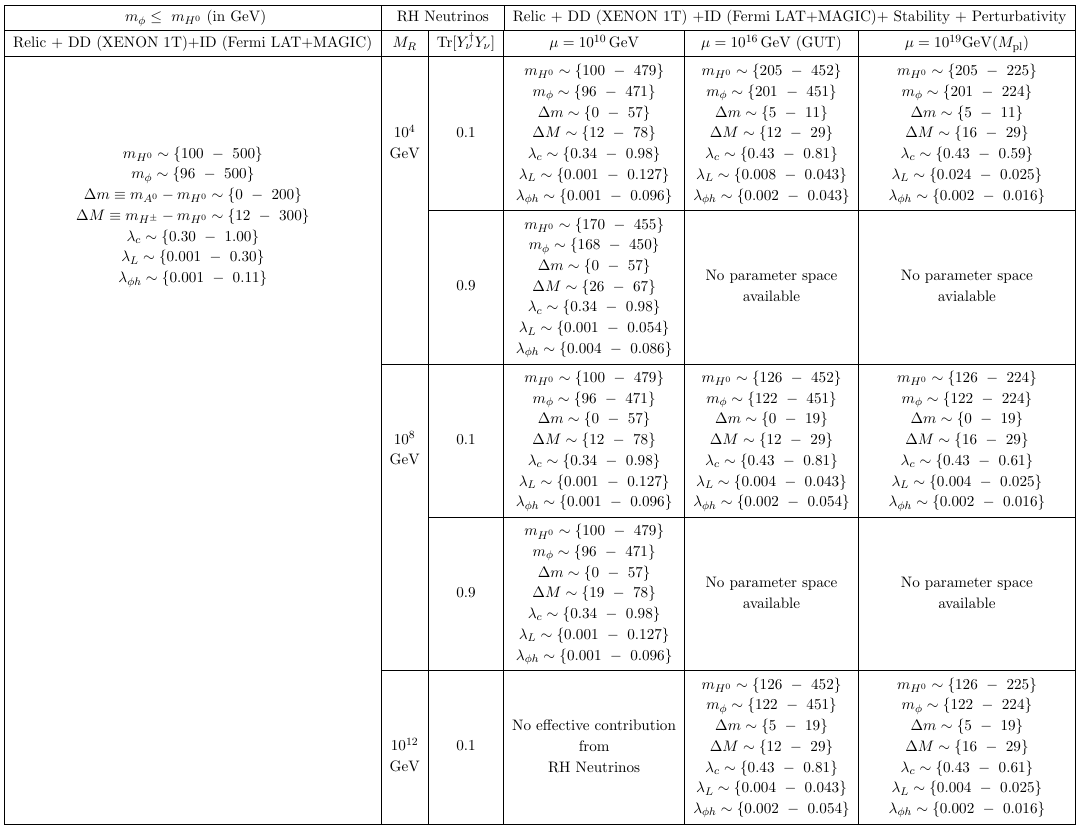
Table 10 . Allowed ranges of relevant parameters considering m (cid:30) (cid:20) m neutrino mass and Tr[ Y y Open